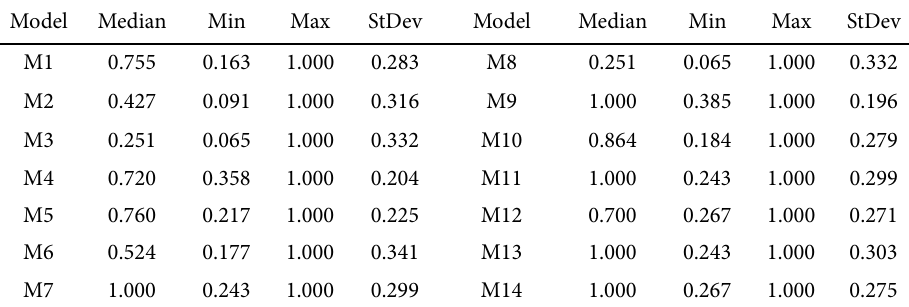
Table 8. Results of the application of M1-M14 models: descriptive